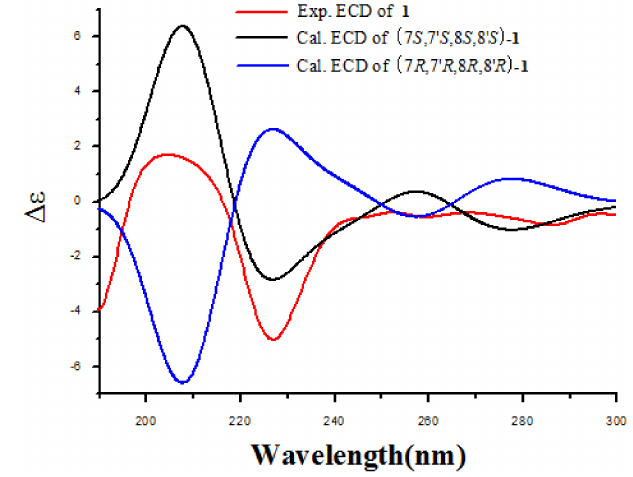
Figure 3. Experimental ECD spectra of compound 1 and the calculated ECD spectra of (7 S ,7 (cid:48) S ,8 S ,8 (cid:48) S )- 1 and (7 R ,7 (cid:48) R ,8 R ,8 (cid:48) R )- 1 .